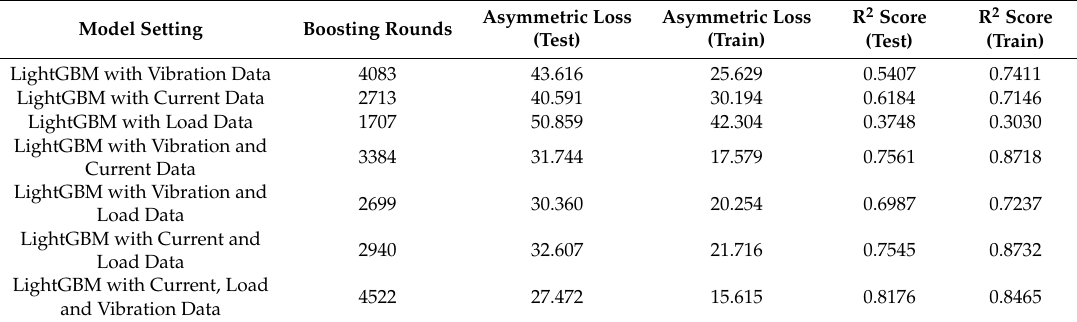
Table 3. Predictions for di ff erent types and di ff erent combinations data